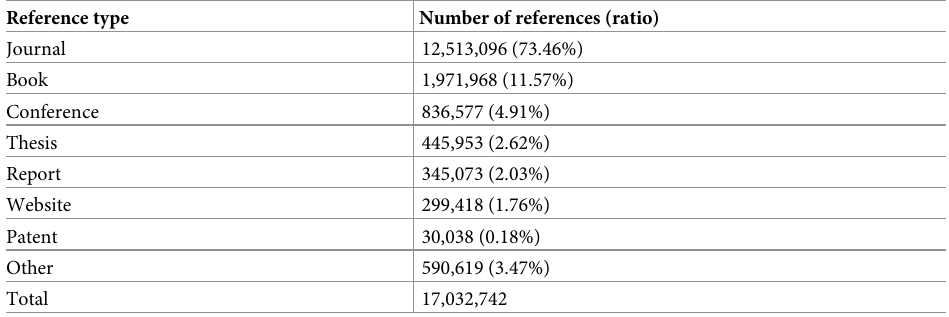
Table 1. Number of references cited in domestic literature in our database as of March 4,